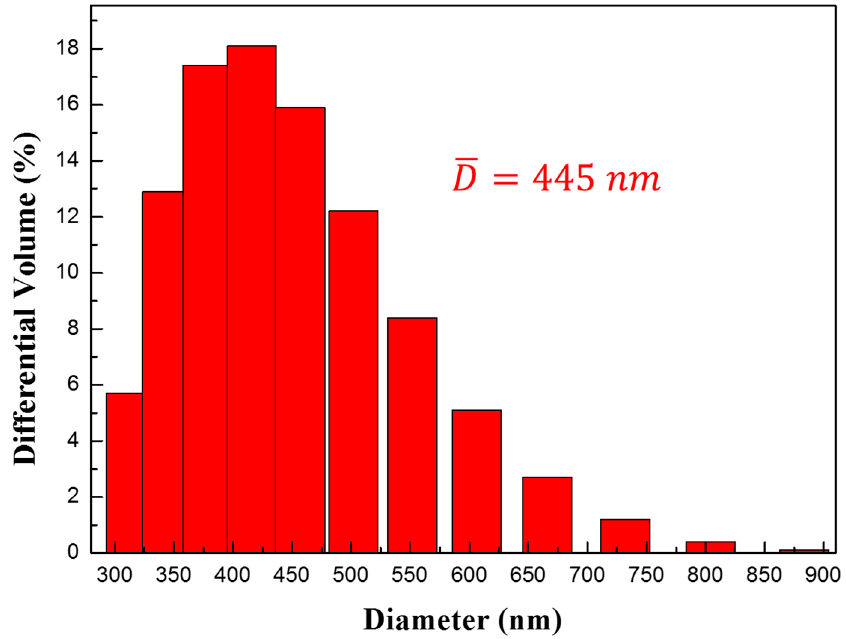
Figure 3. Size distribution of Fe 3 O 4 /POA particles.